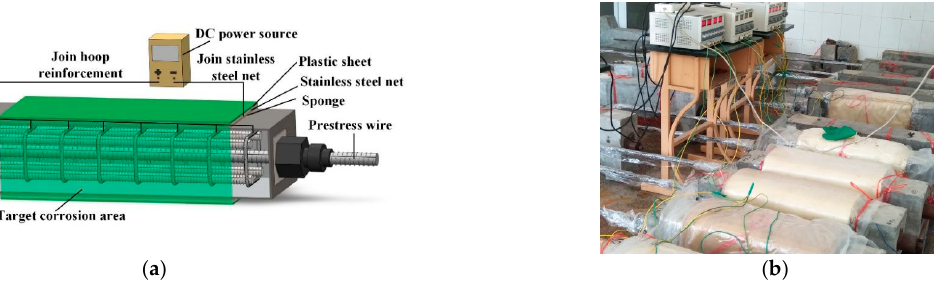
Figure 3. Accelerated corrosion test. ( a ) Diagram of accelerated corrosion. ( b ) Accelerated corrosion site.